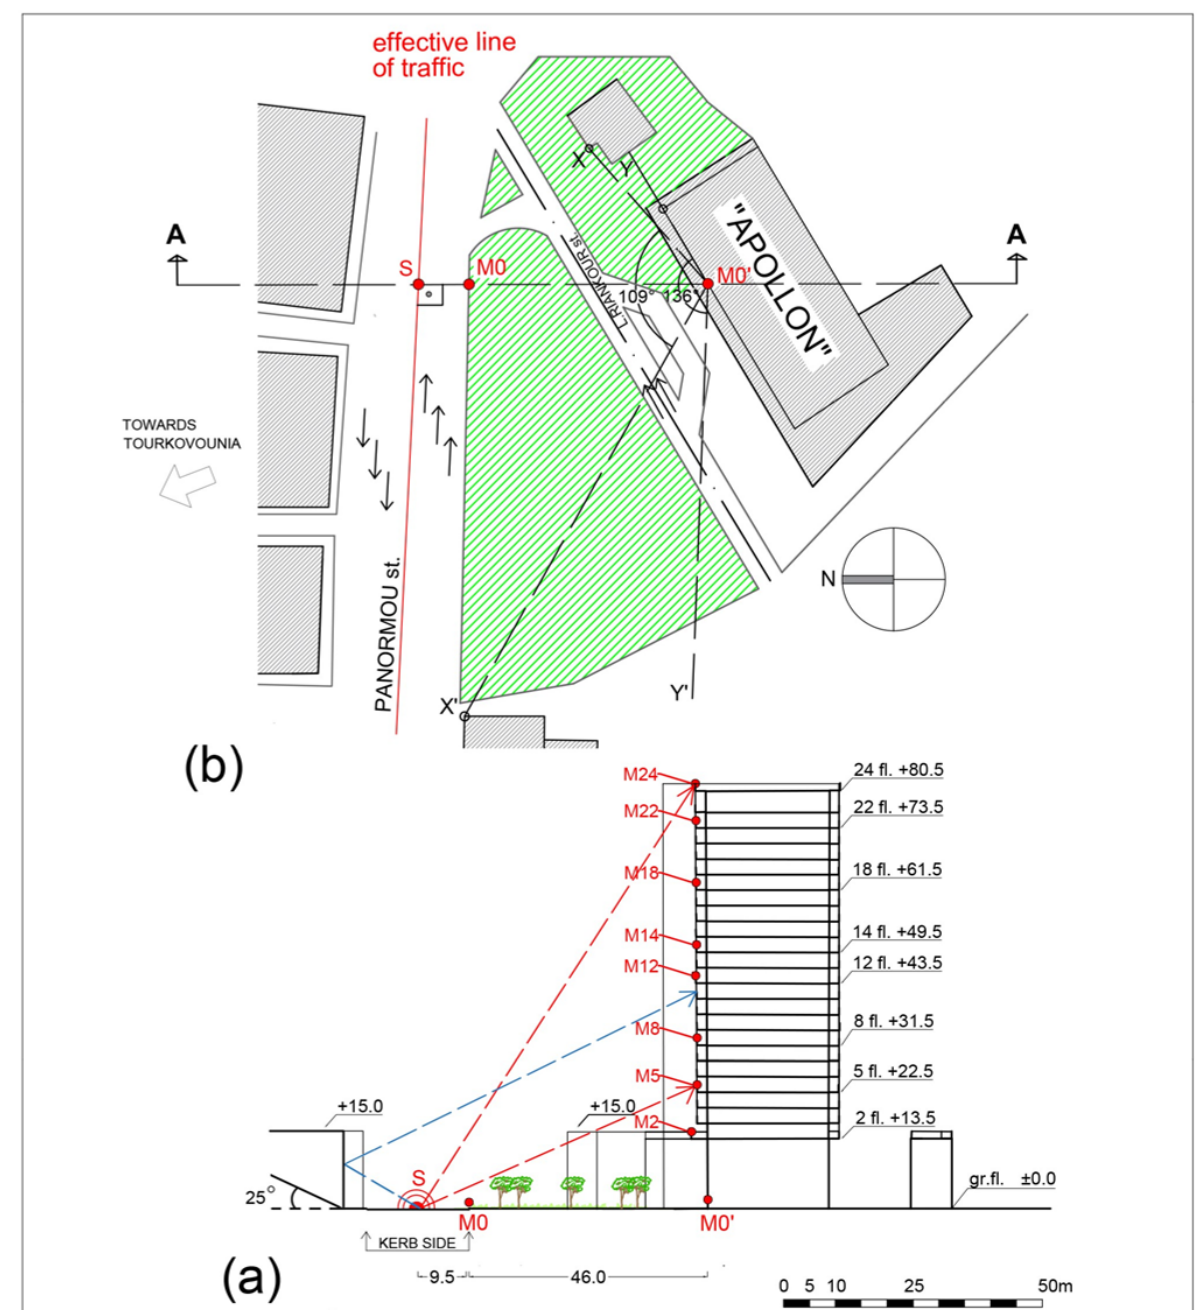
Figure 6: (a) Section and (b) plan of "Apollon”. S: sound source, M0: reference point, M0’: test point on ground floor level, — : direct sound, — : reflected